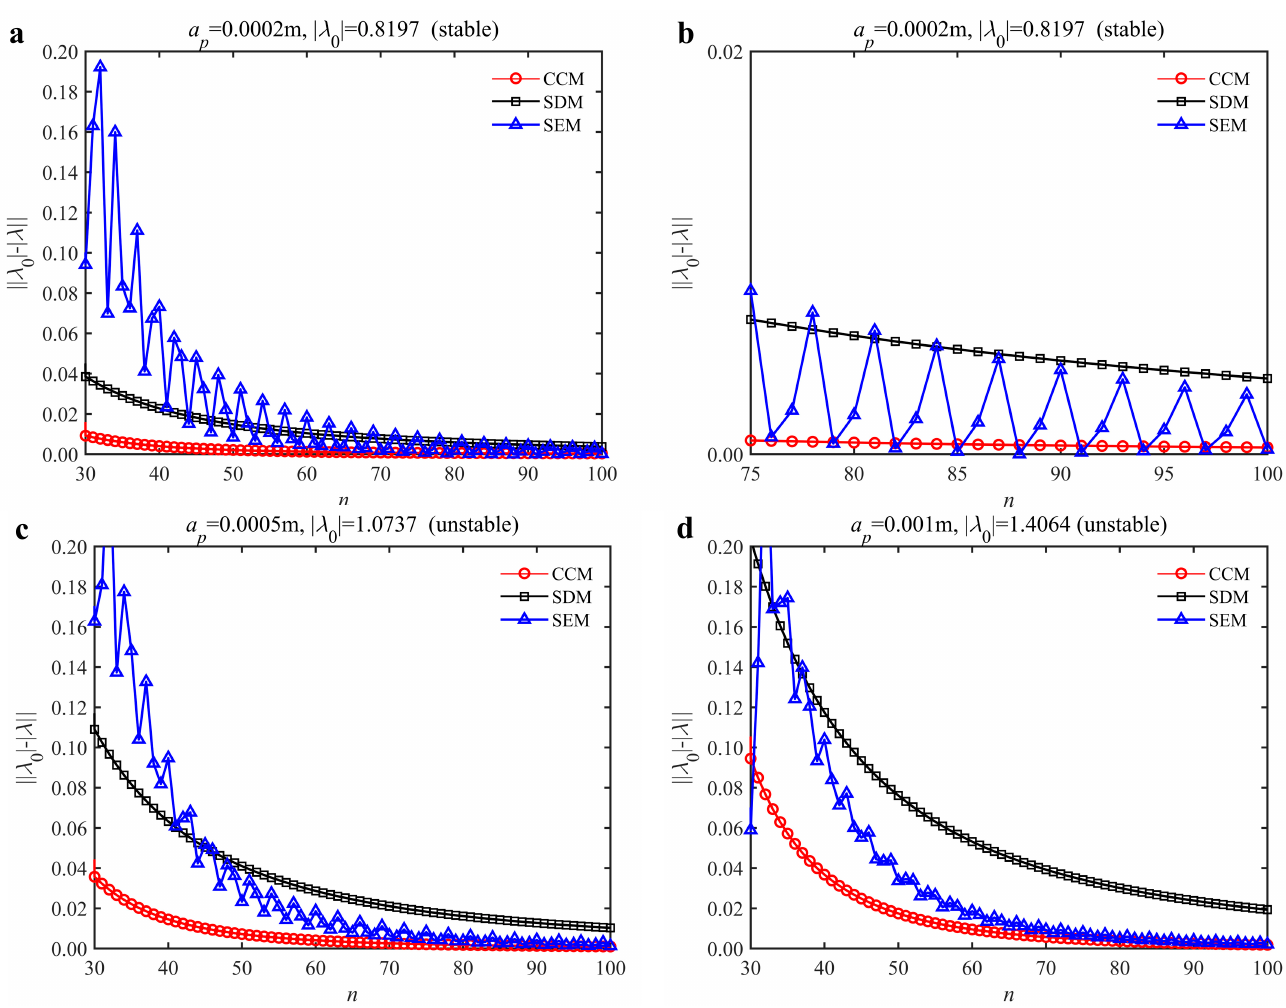
Figure 2. Convergence rate comparisons of the CCM, SDM and SEM when a / D = 1. ( a ) a p = 0.0002 m and n ∈ [30,100]; ( b ) a p = 0.0002 m and n ∈ [75,100]; ( c ) a p = 0.0005 m and n ∈ [30,100]; ( d ) a p = 0.001 m and n ∈ [30,100].